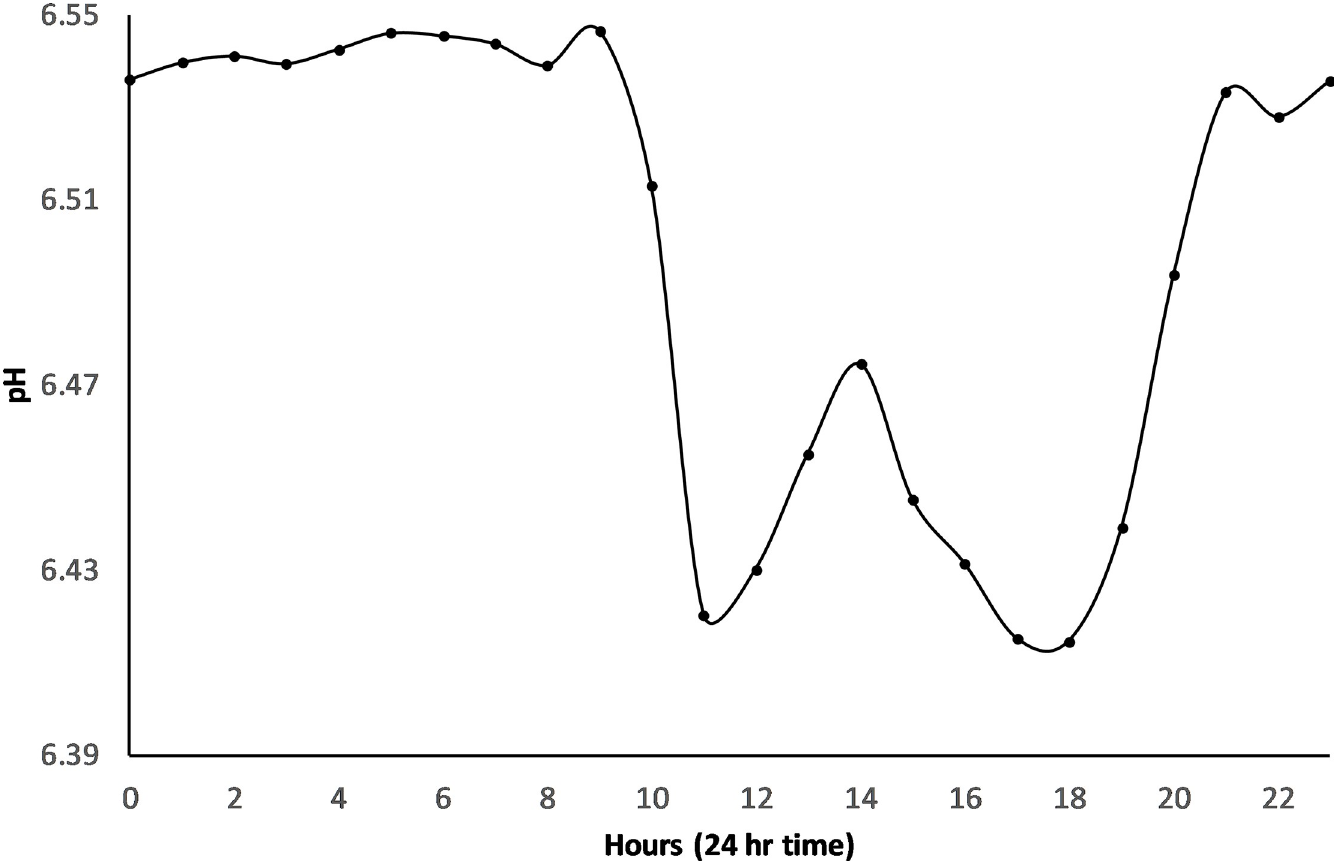
Fig 16. Mean hourly pH for the post bund period– 2014 to